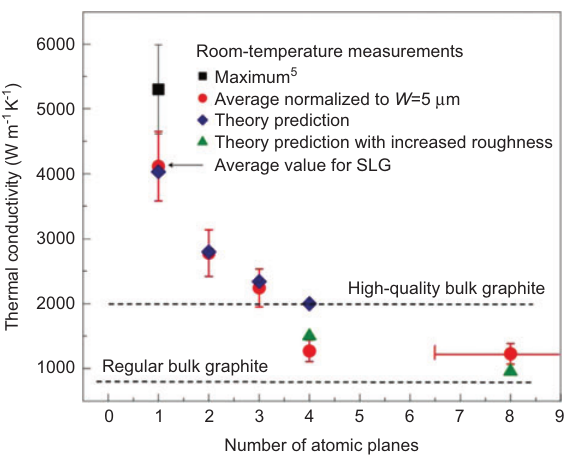
Figure 4 Thermal conductivity of the suspended CVD graphene as a function of the measured temperature of the graphene mono- layer suspended in vacuum over holes of various diameters. Shown in comparison is the value obtained by neglecting heat loss to air or assuming g = 0 from a Raman measurement in air of a sample over a 9.7- μ m hole and the literature thermal conductivity data of pyrolytic graphite samples as a function of temperature. (Reproduced from Ref. [44] with permission from the American Chemical